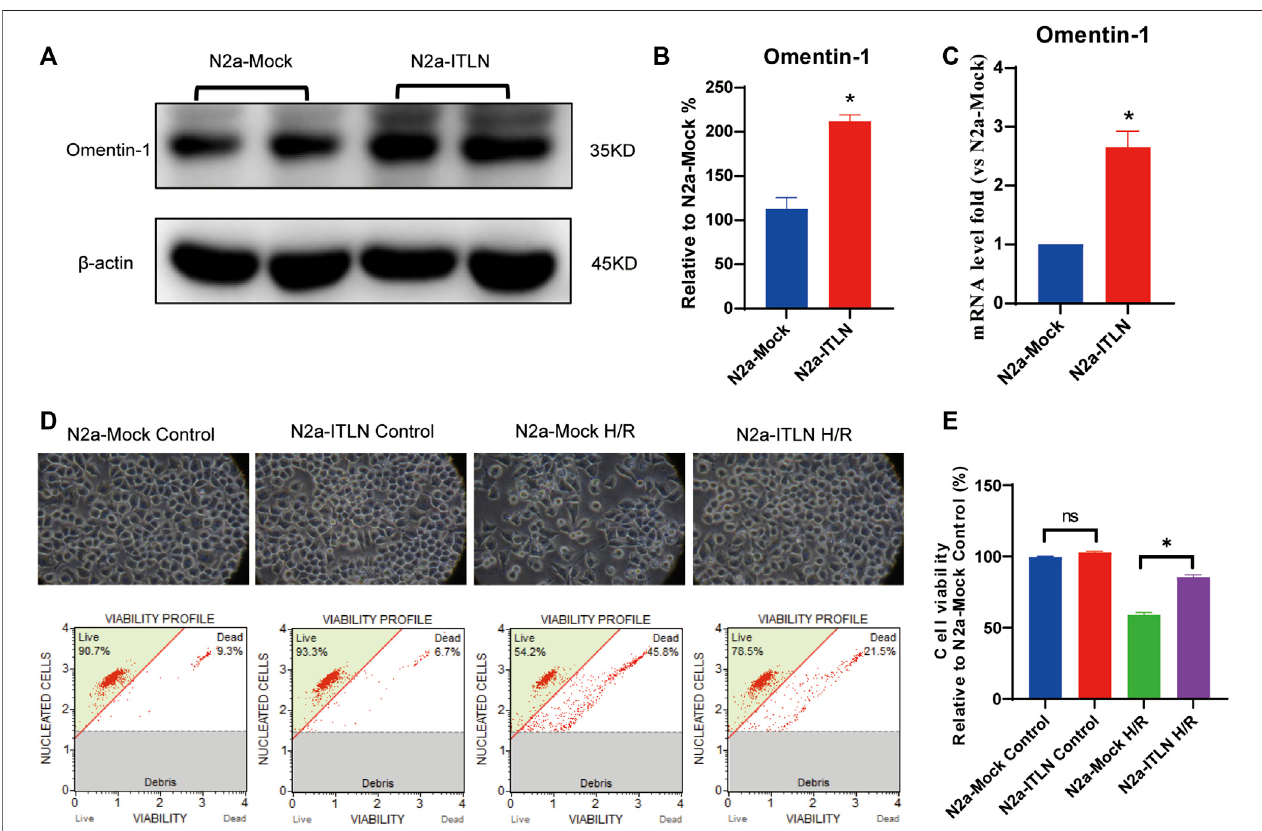
FIGURE 8 | Omentin-1 overexpression protected N2a cells against H/R-induced injury. (A) The representative images of omentin-1 detected by Western blot. (B) Quantitative analysis of Western blot by normalizing to β -actin. (C) qRT – PCR analysis of omentin-1 mRNA expression normalized to the β -actin. (D) Toxicity of the omentin-1 overexpression in N2a cells (Control or H/R treated). (E) Statistical graph of cell viability. ITLN (cid:2) Omentin-1. Error bars show the standard deviation for n (cid:2) 6 measurements from representative experiments. * p < 0.05 vs. the N2a-Mock group; ns, non-signifcant.